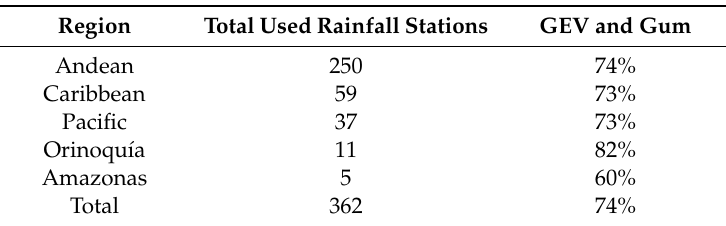
Table 5. Percentages for GEV and Gumbel distributions.